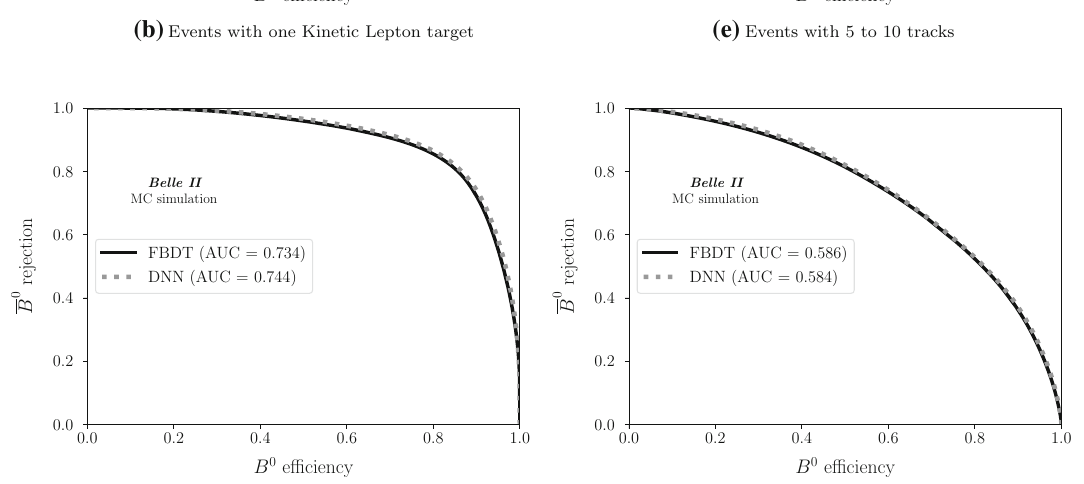
events with one target particle of the Kinetic Lepton category and events with one target particle of the Kaon category, and (right) events with less than 5 tracks, with 5 to 10 tracks and with more than 10